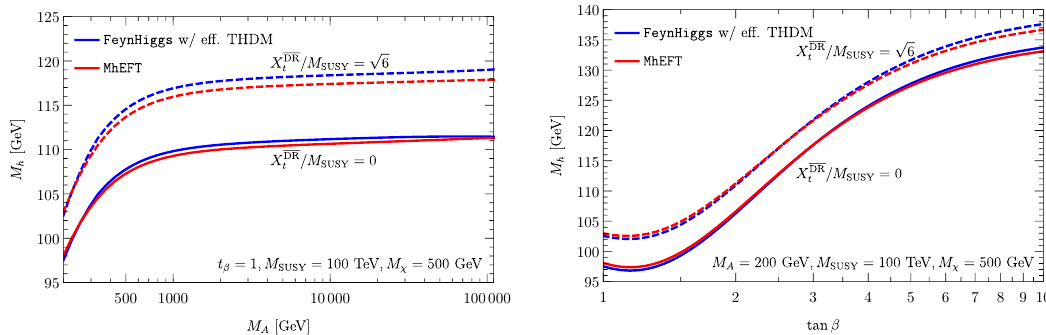
Figure 11 . Left: M h as a function of M A for tan (cid:12) = 1. Right: M h as a function of tan (cid:12) for M A = 200 GeV. The results of FeynHiggs with e(cid:11)ective THDM (blue) and MhEFT (red) are p compared for X DR =M SUSY = 0 (solid) and X DR =M SUSY = 6 (dashed). t t